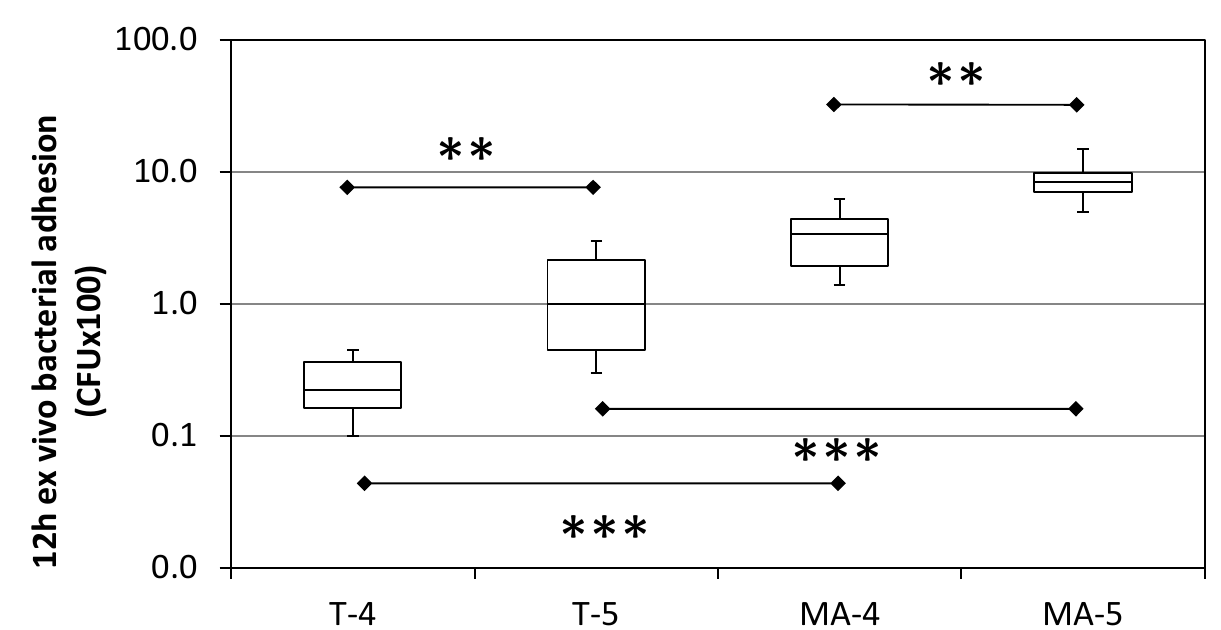
Figure 5. Bacterial adhesion on turned (T), mildly acid-etched (MA), grade 4 and grade 5 Ti implant surfaces after 12 h ex vivo staying in the mouth. Data are expressed as counts of Colony Forming Units (CFU) on a logarithmic scale (median, interquartile range, minimum/maximum). N = 12. ** = p < 0.01; *** p < 0.001.